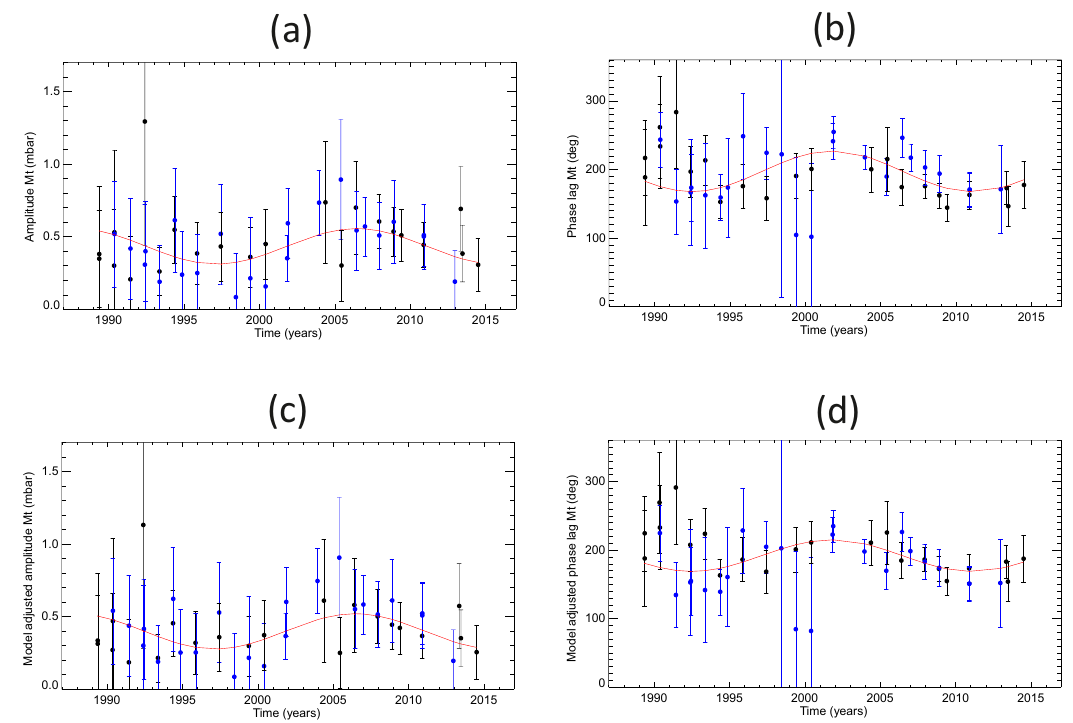
Figure 7. Panels (a, b) are the same as Fig. 5a, b but for the Mt long-period tide. Panels (c, d) are the same as (a, b) but with adjustments using the FES2014